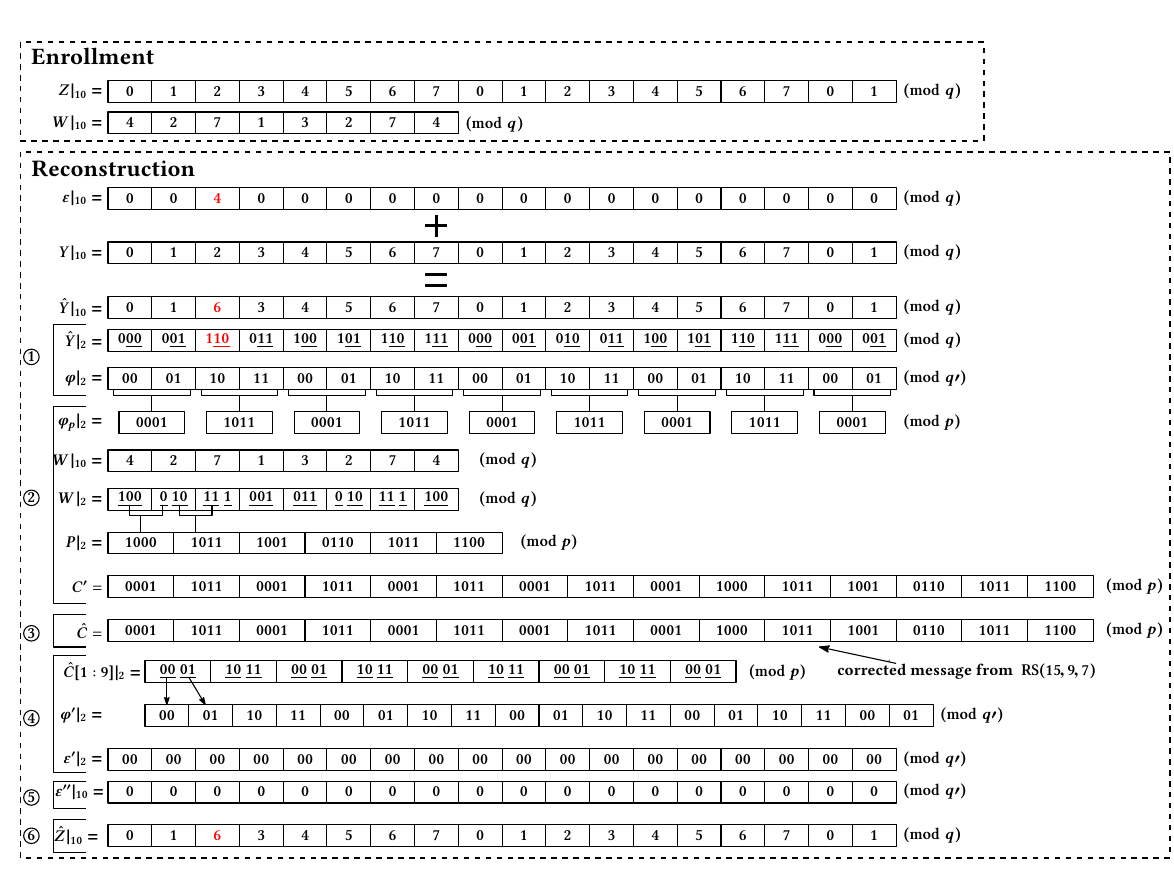
Figure 13: LMC example for decoding failure (q=8, q 0 = 4 , l u = 2 , l d = − 1,